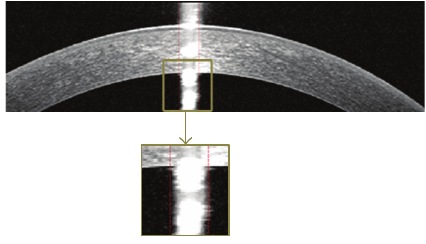
Figure 5: An example of central artifact positioning.